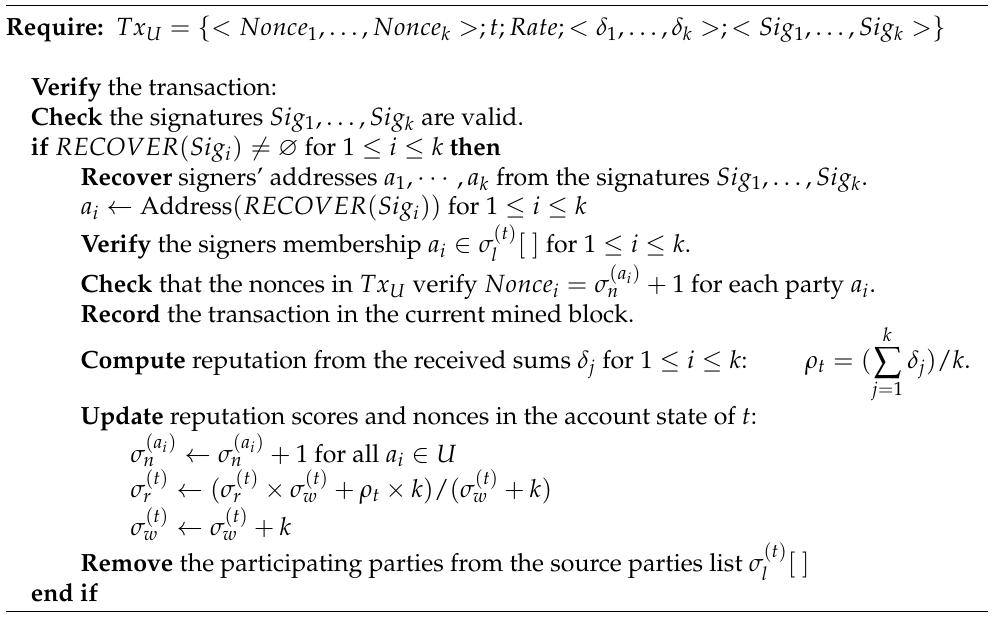
Algorithm 3 Phase 3: Reputation aggregation on-chain (performed by